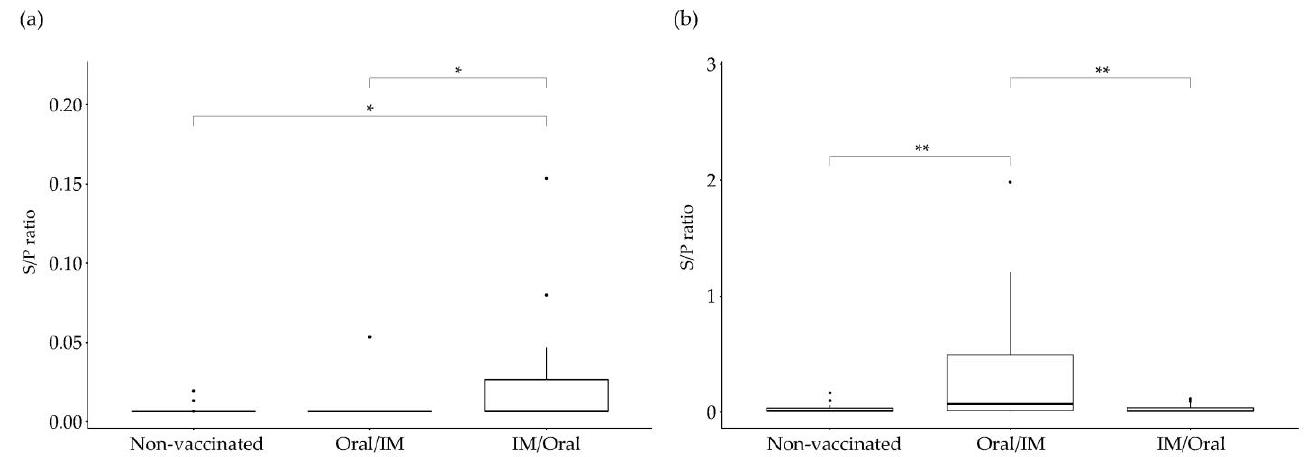
Figure 2. Salmonella Enteritidis-specific antibody titers induced by vaccination. Blood samples were collected at ( a ) three weeks after prime vaccination, and ( b ) two weeks after booster vaccination. Serum was isolated from the blood and S . Enteritidis-specific antibody titers were measured with a commercial ELISA kit. Each bar represents the mean sample to positive (S/P) ratio. Oral/IM, prime-boost vaccinated group with the candidate strain via oral–intramuscular route; IM/Oral, prime-boost vaccination with the candidate via intramuscular–oral route. * p < 0.05; ** p < 0.005.